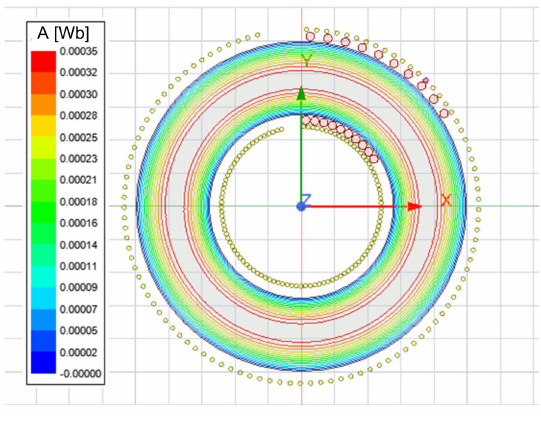
Figure 11. Magnetic flux.